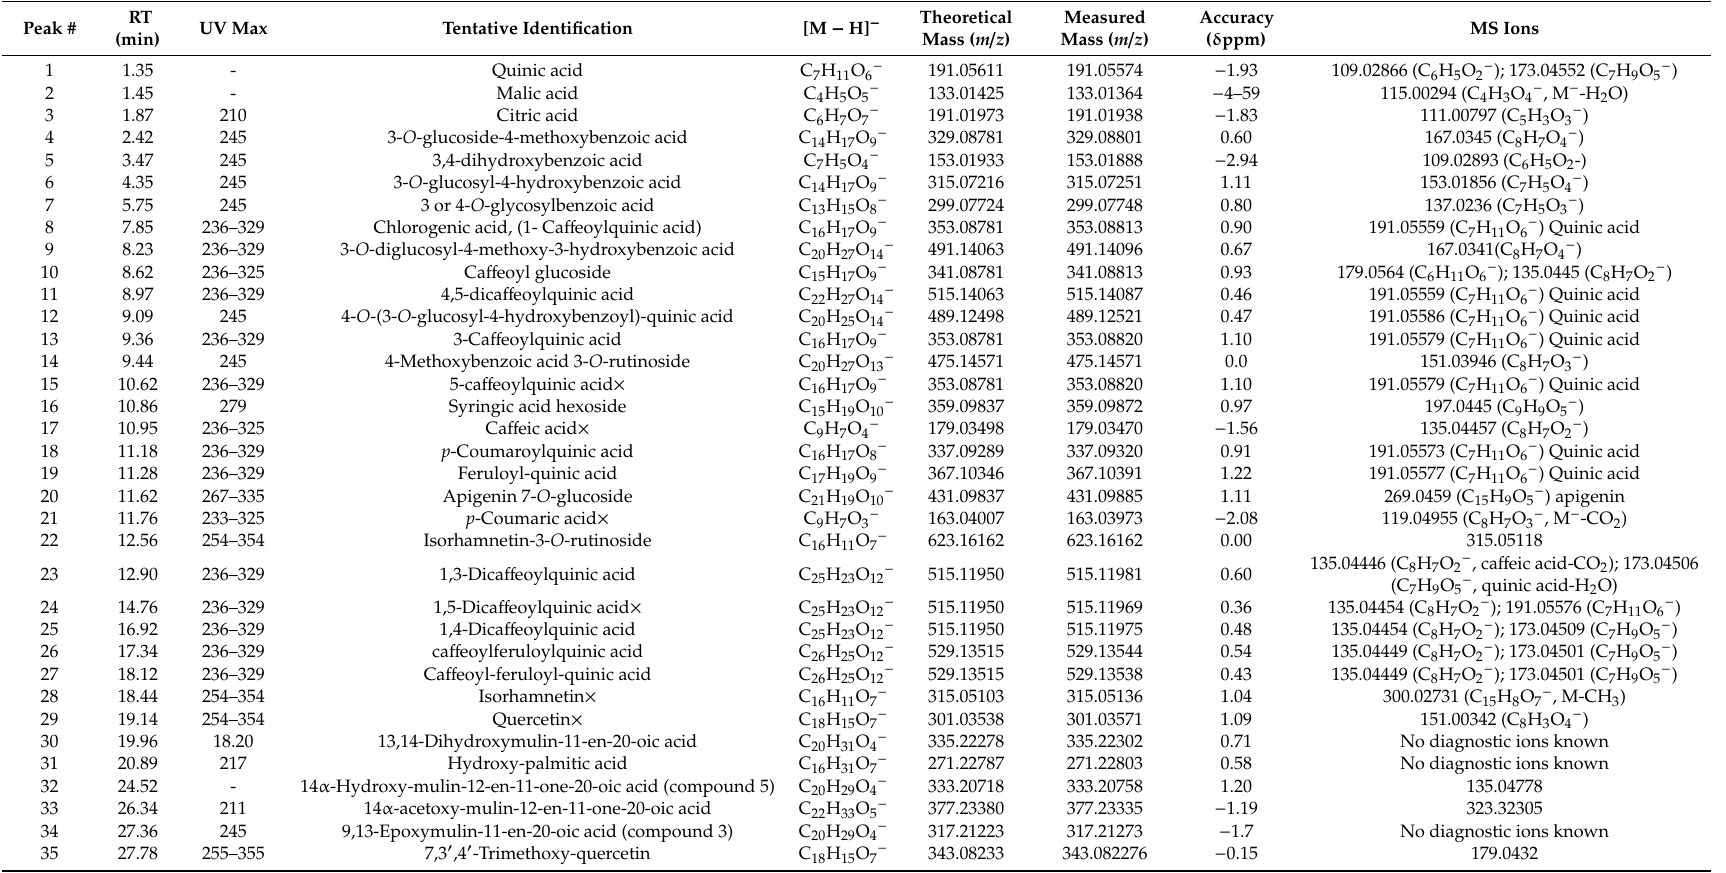
Table 2. UHPLC / ESI / MS spectral data of edible infusion of Mulinum crassifolium